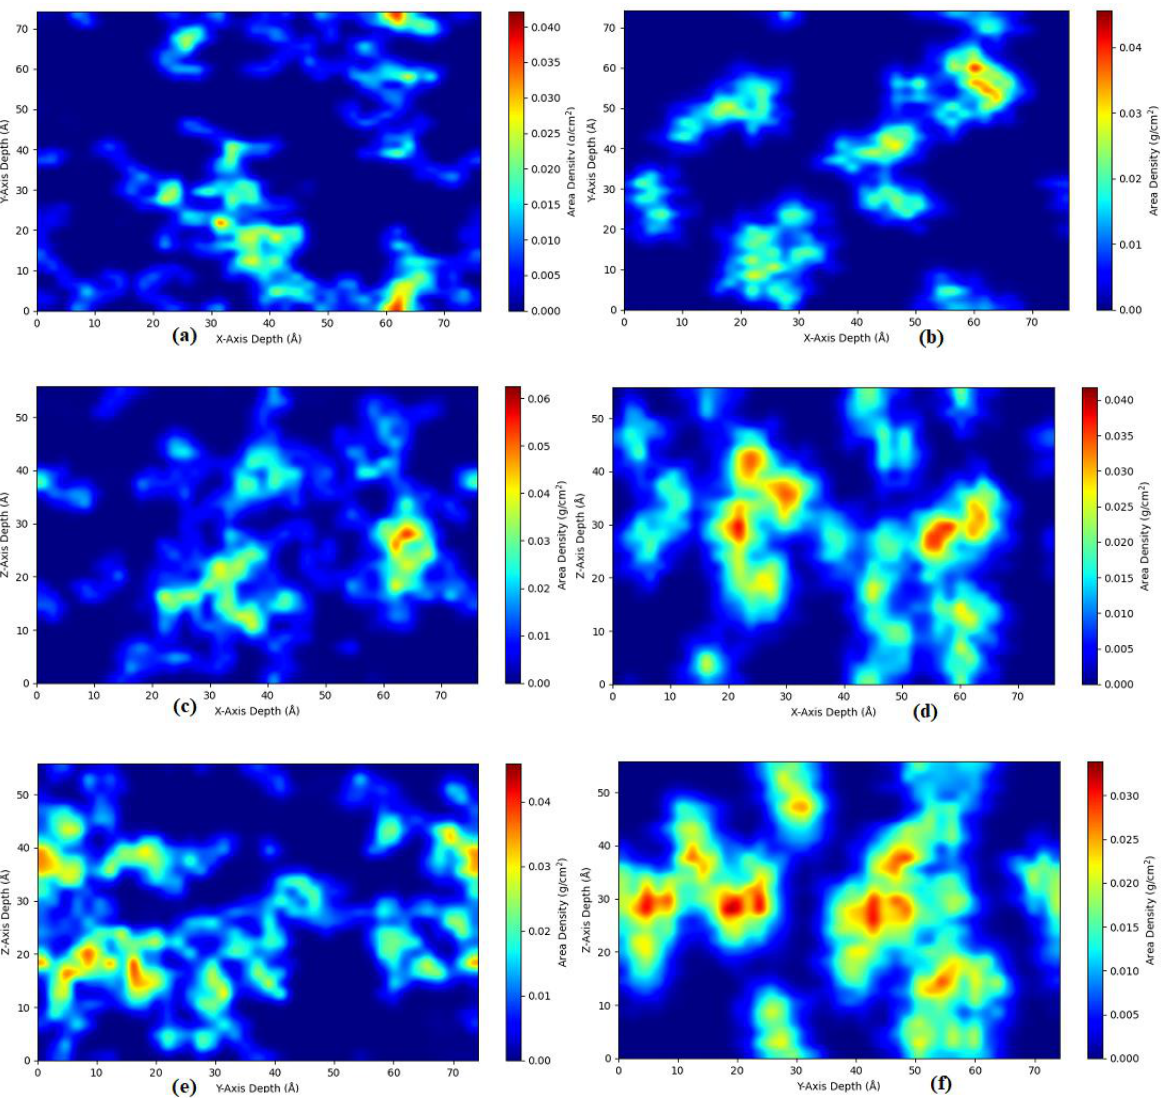
Figure 5. POSS density projection plot ( a , c , e ) — MAPOSS10, ( b , d , f ) — MIPOSS10.